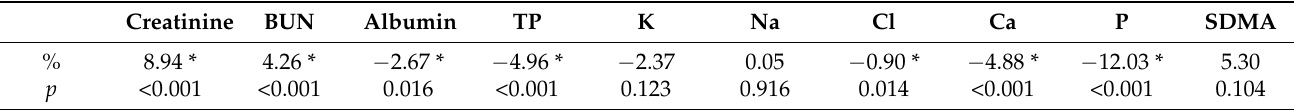
Table 3. This table presents the percentage differences and statistical significances of the serum parameter concentrations before and after freezing. A positive percentage value means an increase and a negative percentage value a decrease in an analyte